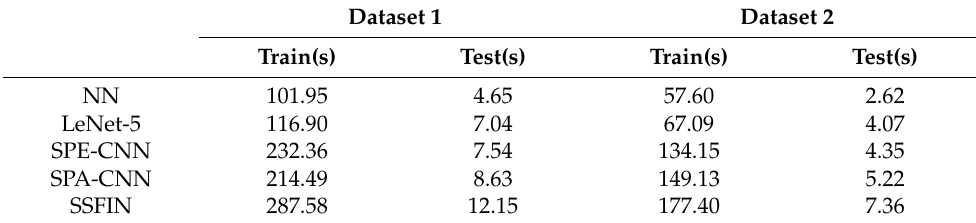
Table 10. Time cost of dataset 1, dataset 2, and Pavia